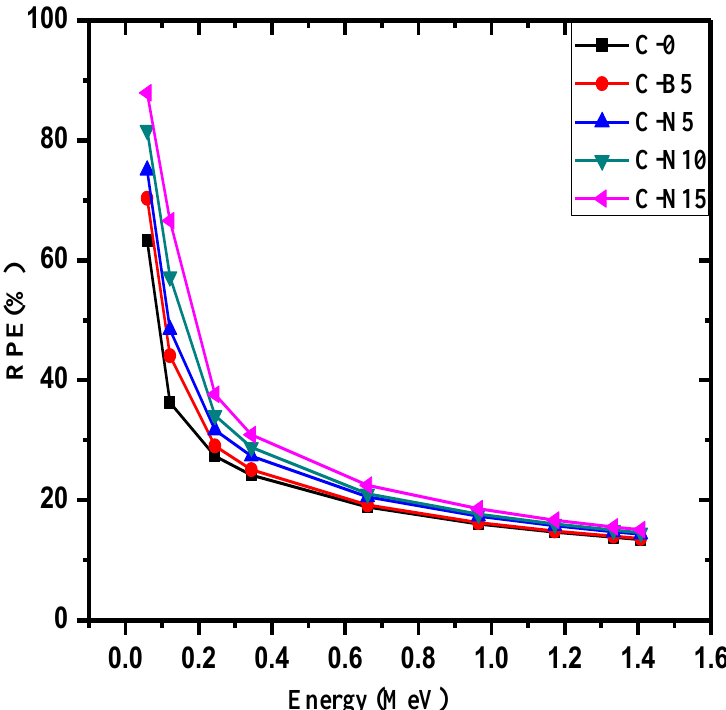
Figure 9. The radiation protection efficiency (RPE) of the prepared concretes.